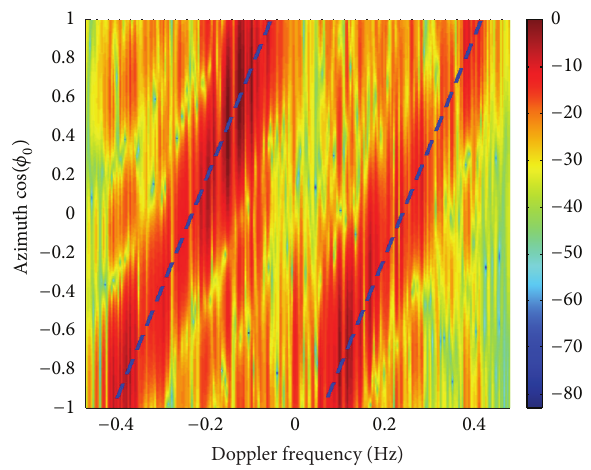
Figure 3: Spread spectrum of real first-order sea clutter. Figure 4: Space-time spectrum of real sea clutter. - - denotes the theoretical value of first-order sea clutter in